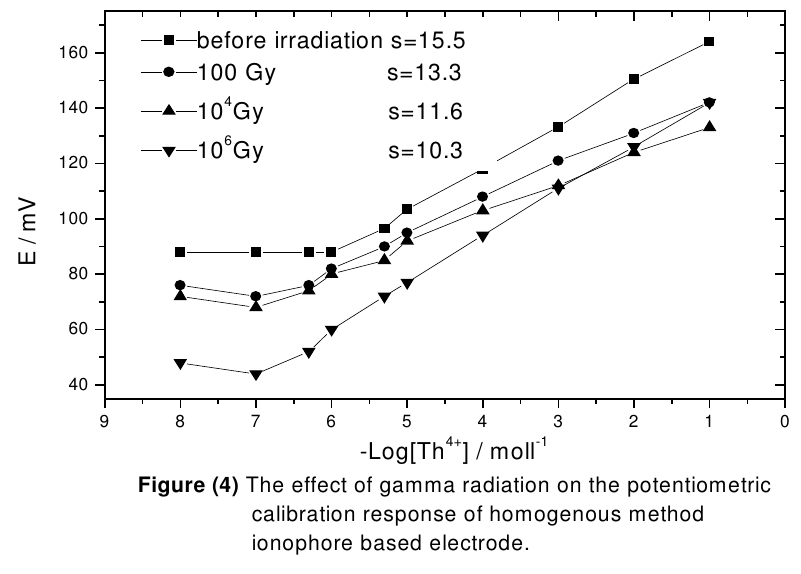
Figure (4) The effect of gamma radiation on the potentiometric calibration response of homogenous method ionophore based electrode.